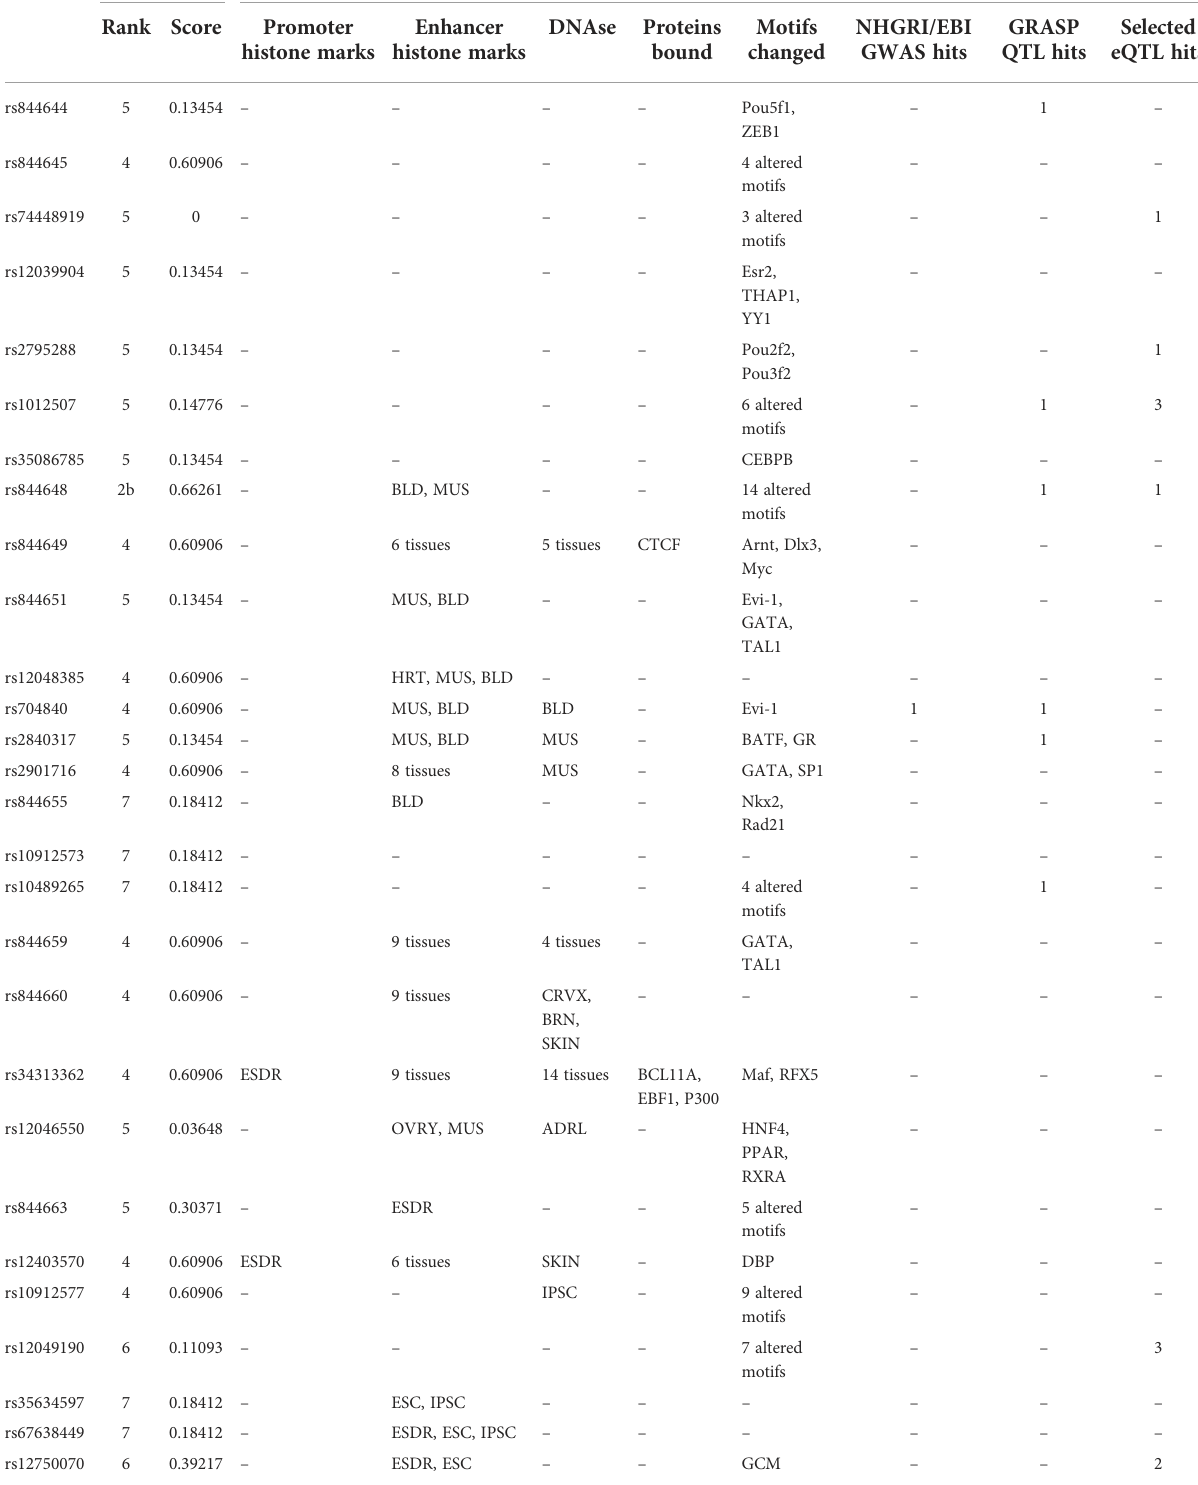
TABLE 3 Functional annotations by RegulomeDB and